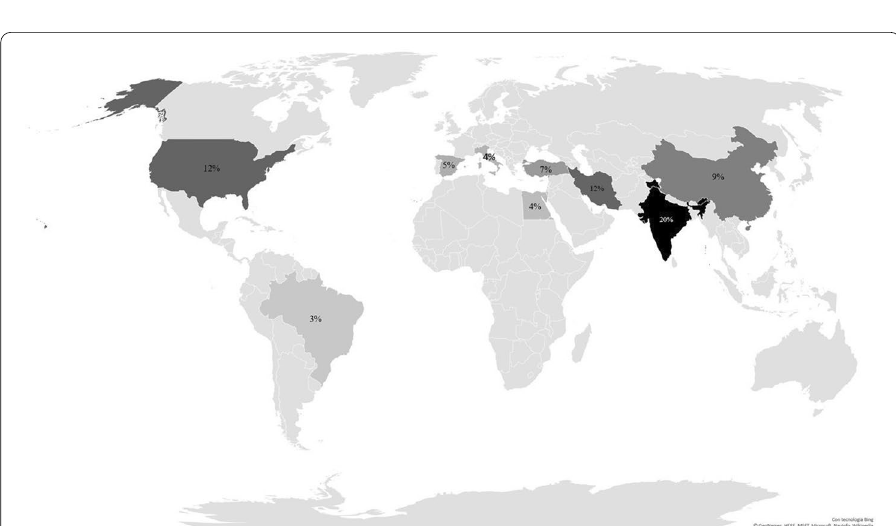
Fig. 3 Number of publications by country (7743: first 10 countries). Note: the percentages of articles published by the first 10 countries (for quantity of articles) are as follows: India–20%; USA–12%; Iran–12%; China–9%; Turkey–7%; Spain–5%; Italy–5%; Egypt–4%; Israel–3%;